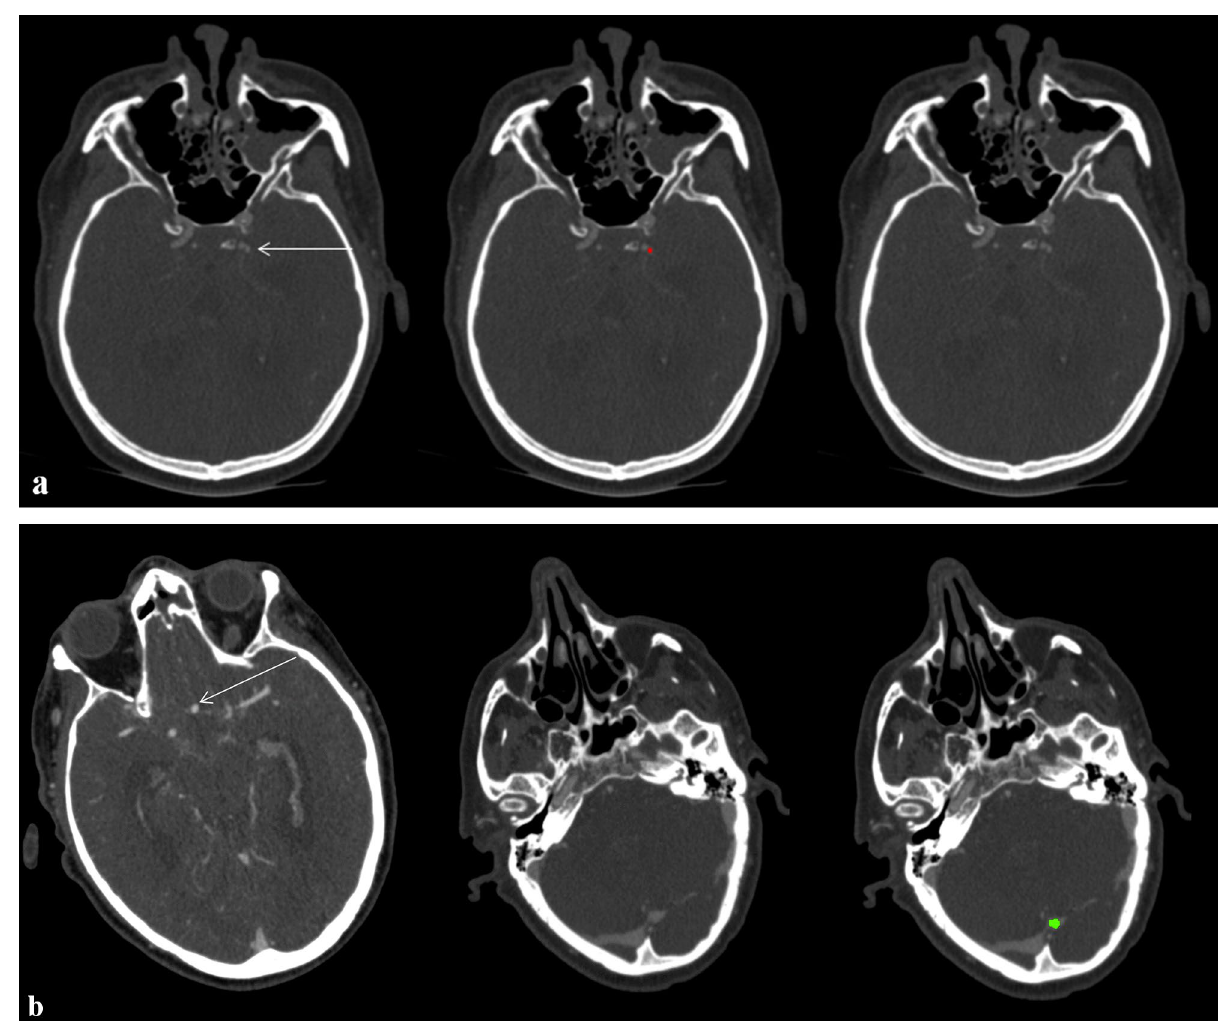
Figure 6. ( a ) Axial CTA source images of a 64-year-old male with a small aneurysm (volume based on manual segmentation: 21.8 mm 3 ) of the left internal carotid artery (arrow, red: manual segmentations) being missed by the DLM-Ens. ( b ) Axial CTA source images of a 65-year-old male with an anterior communicating artery aneurysm (arrow), which was accurately segmented and detected by the DLM. However, a false positive finding of the DLM-Ens (in green) at the superior sagittal sinus/transverse sinus was